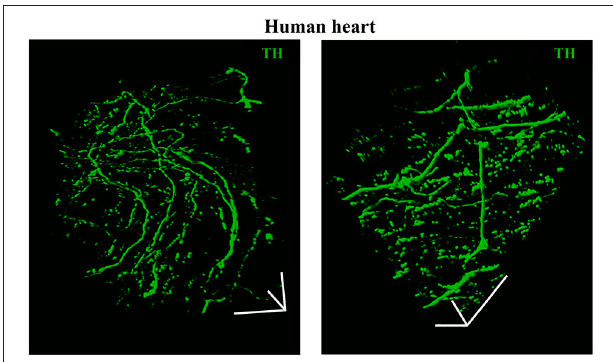
FIGURE 6 | Three-dimensional imaging of the neuronal network in the human myocardium. Topology of the SN network, reconstructed with 3-D rendering of 600 images acquired with a multiphoton microscope along 200 µ m, upon whole-mount immunofluorescence in 1 mm 3 LV blocks from the EPI region, stained with anti-TH antibody. Images were acquired with an 18 × objective, 1.1 NA, allowing a large field of view (850 × 850 µ m) at high resolution. A segment of (850 × 850 × 200) µ m was imaged. mage series were acquired along the Z-axis, with a step size of 1.5 µ m and processed and analyzed with a software for 3-D rendering (Imaris). Images modified with permission from Pianca et al.